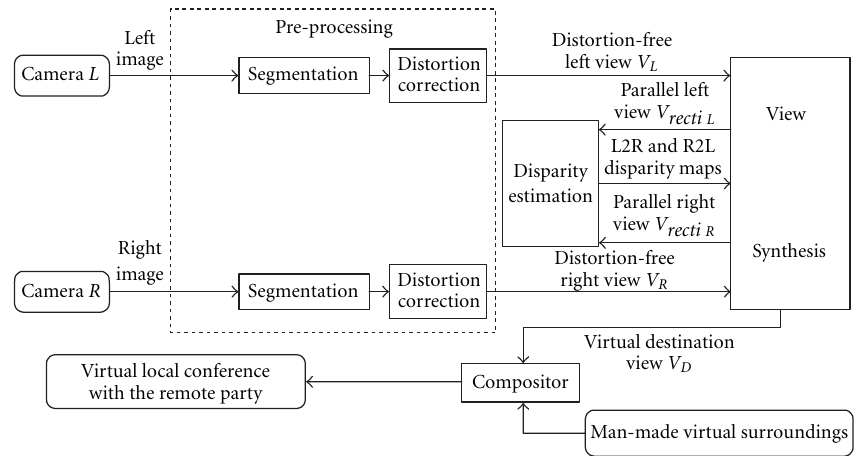
Figure 3: The processing chain for adapting the synthesized look of one participant in line with the viewpoint change of another participant. Based on a pair of stereo sequences, the “virtually” perceived view should be reconstructed and integrated seamlessly with the man-made uniform environment in real